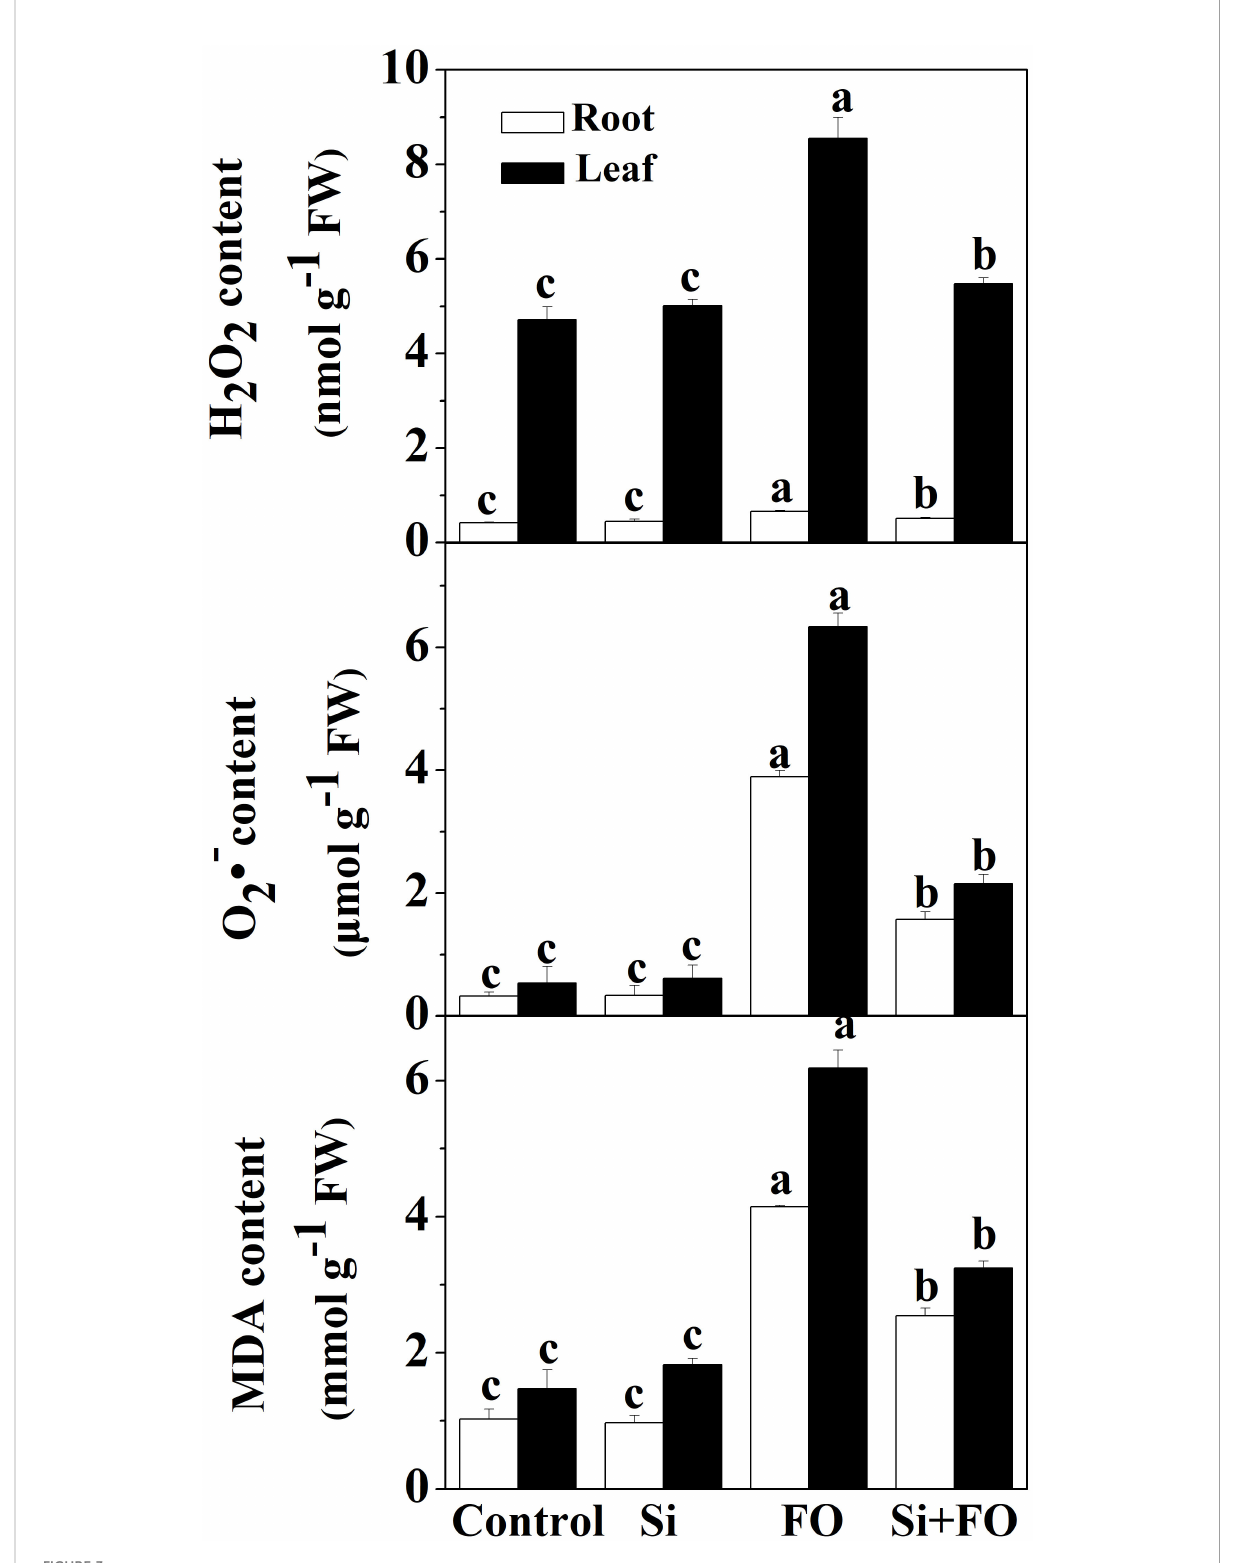
FIGURE 3 Effects of exogenous silicon application on the contents of H 2 O 2 , O · − 2 , and MDA in cucumber roots. Means denoted by the different lowercase letters are signi fi cantly different according to Tukey ’ s test ( P ≤ 0.05); the mean represents the average of three replicates ± standard deviation (SD). Control: plants were irrigated with sterilized water; Si: plants were irrigated with exogenous silicon (3 mmol·l -1 Si); FO: plants were only inoculated with Fusarium ; Si+FO: plants were irrigated with exogenous silicon followed by inoculation with Fusarium